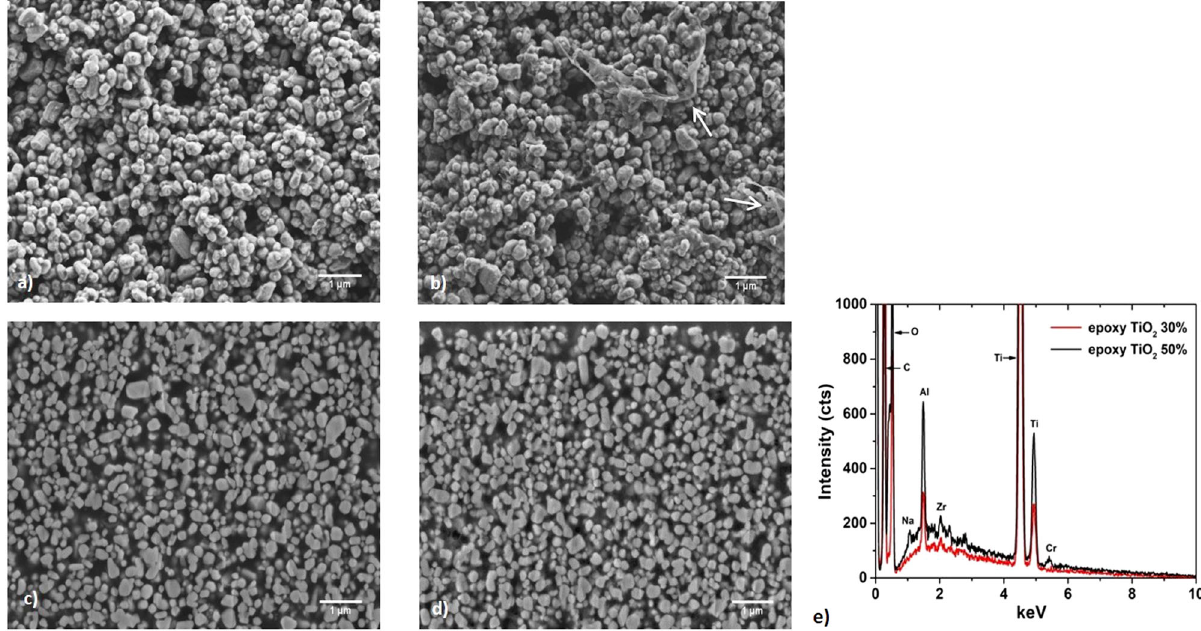
Fig. 5 SEM/EDS analysis of 50TiO 2 fi lm after 14 days of exposure to aqueous Na 2 CrO 4 solution at 60 °C. a SEM image of 50TiO 2 surface before exposure. b SEM image of 50TiO 2 surface after 14 days of exposure to aqueous Na 2 CrO 4 solution at 60 °C. c SEM image of 50TiO 2 cross section before exposure. d SEM image of 50TiO 2 cross section after 14 days of exposure to aqueous Na 2 CrO 4 solution at 60 °C. e EDS spectra from the middle part of the cross sections of 50TiO 2 and 30TiO 2 fi lms after exposure to the aqueous solution of Na 2 CrO 4 for 14 days at 60